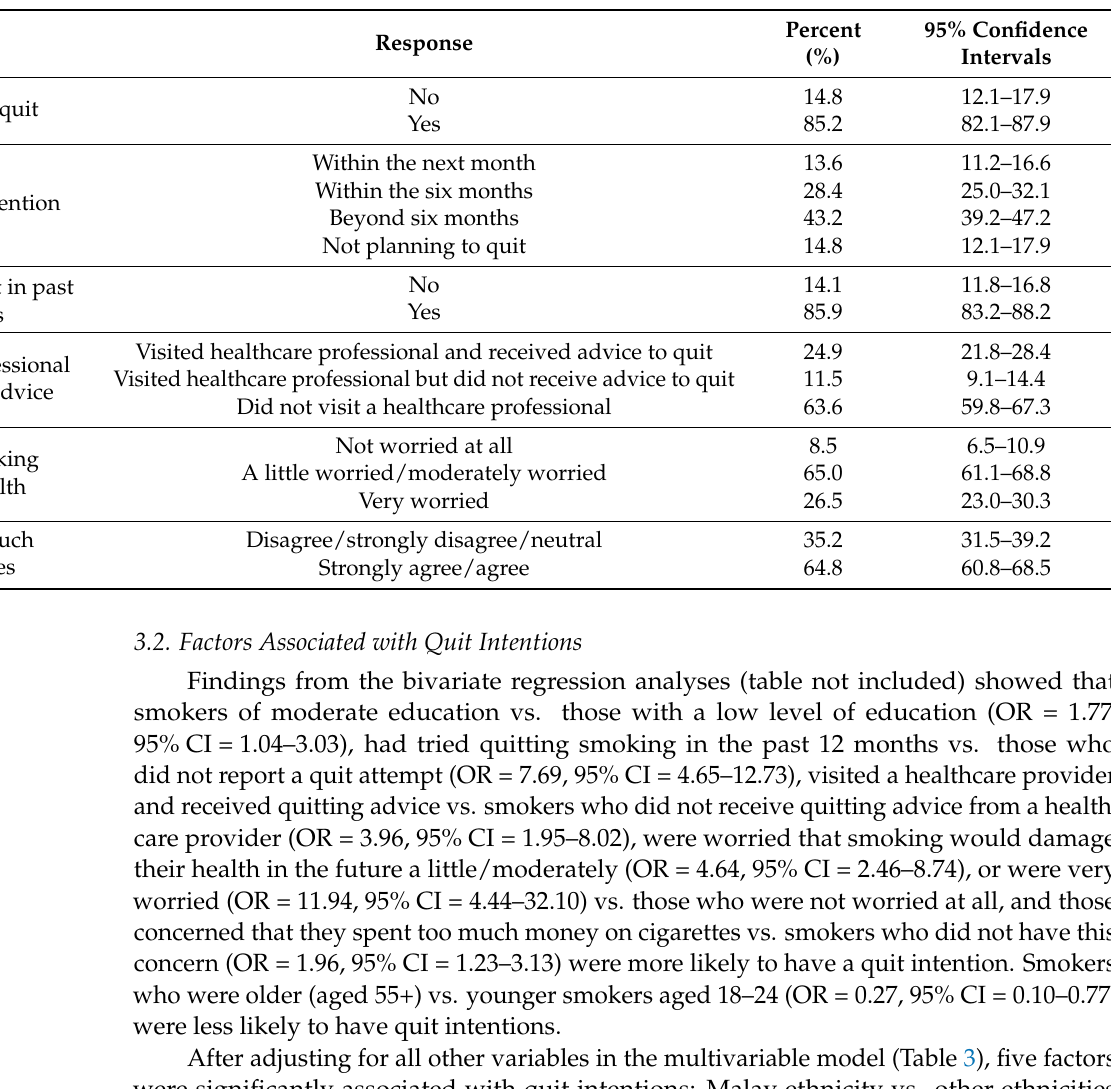
Table 2. Smoking-related measures